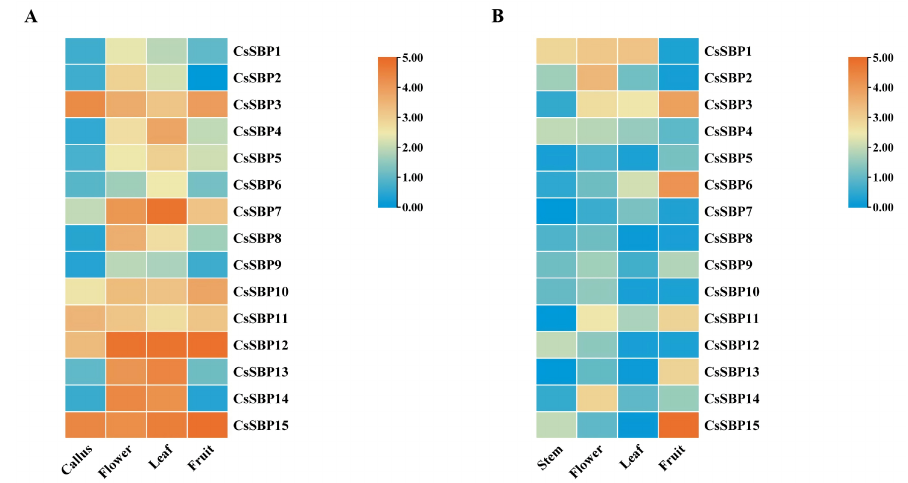
Figure 7. Heatmap showing the expression of CsSBP genes in different tissues. ( A ) Gene expression in the RNA-seq Data. ( B ) qRT-PCR analysis of CsSBP genes expression in different tissues. The log 2 fold change values were used to generate heat maps. Color gradient from orange to blue indicates that expression values change from high to